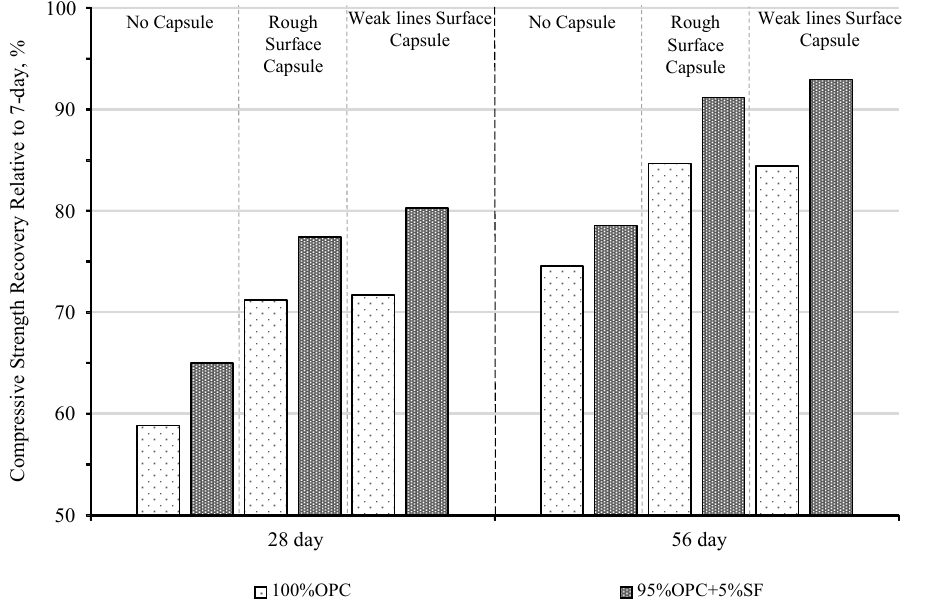
Figure 11. Strength recovery performance of cementitious combinations with various capsules’ surface modification.